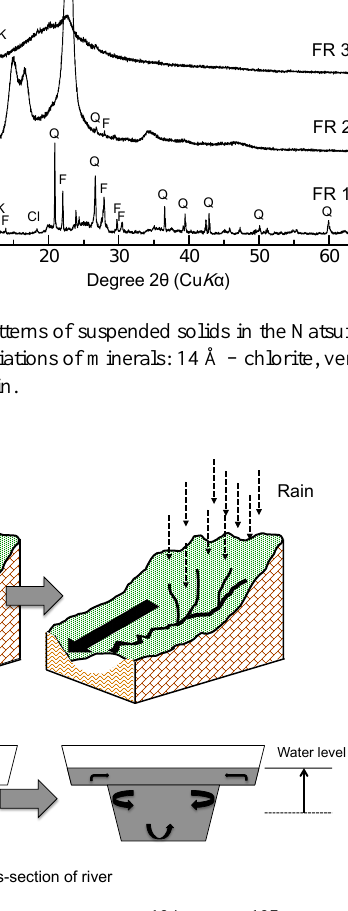
Fig. 6. Schematic illustrations of export of 134 Cs and 137 Cs from watersheds to